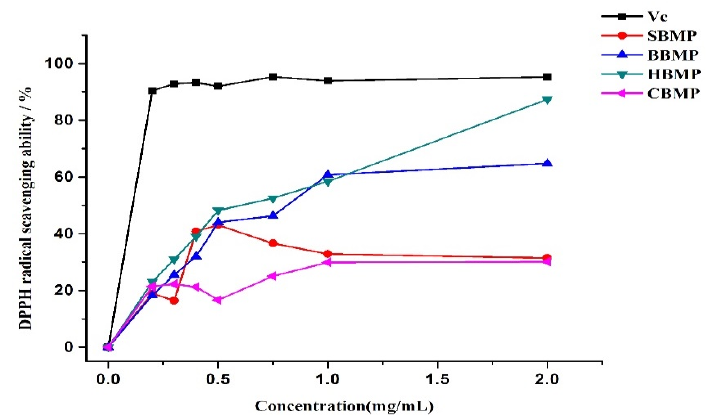
Figure 8. DPPH radical scavenging activity.